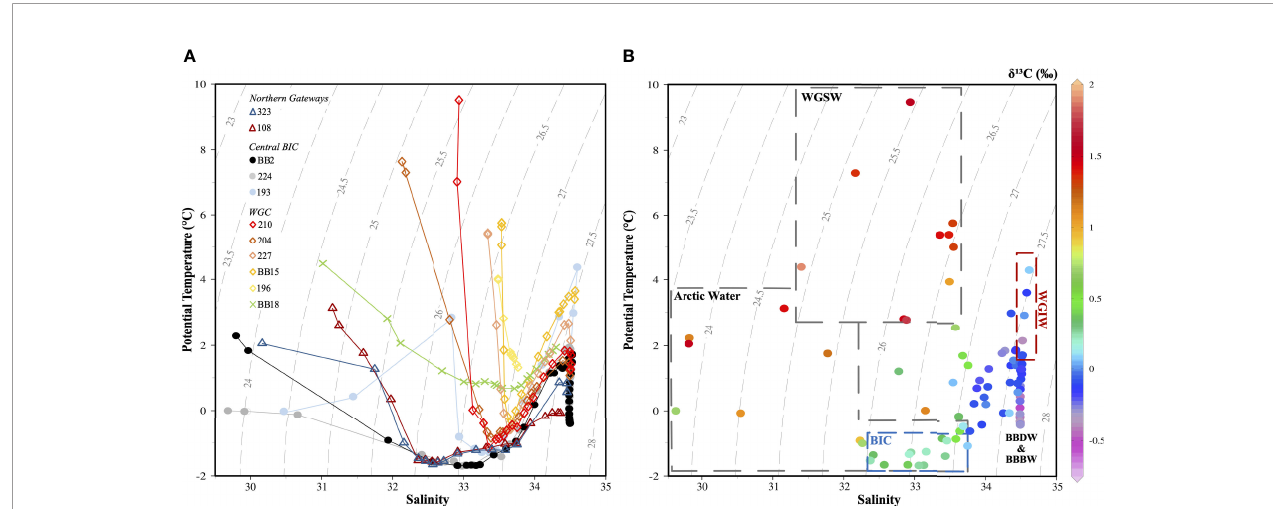
FIGURE 3 | Potential temperature-salinity diagram with DIC d 13 C values throughout Baf fi n Bay. (A) Bottle salinity and potential temperature values plotted for each collected station. Different sampled stations ( Figure 1 ) indicated by legend; Baf fi n Island Current (circles), Western Greenland Current (diamonds), Northern gateways (triangles). Dashed grey lines represent potential density anomaly contours. (B) Potential temperature versus salinity with DIC d 13 C (color bar). Dashed boxes indicate designated currents and water masses; Arctic Water (AW), western Greenland shelf water (WGSW), Baf fi n Island current (BIC), West Greenland Irminger water (WGIW), and Baf fi n Bay deep and bottom water (BBDW; BBBW). Note: fewer data points on plot b are since not all Niskin bottle depths were sampled for DIC d 13